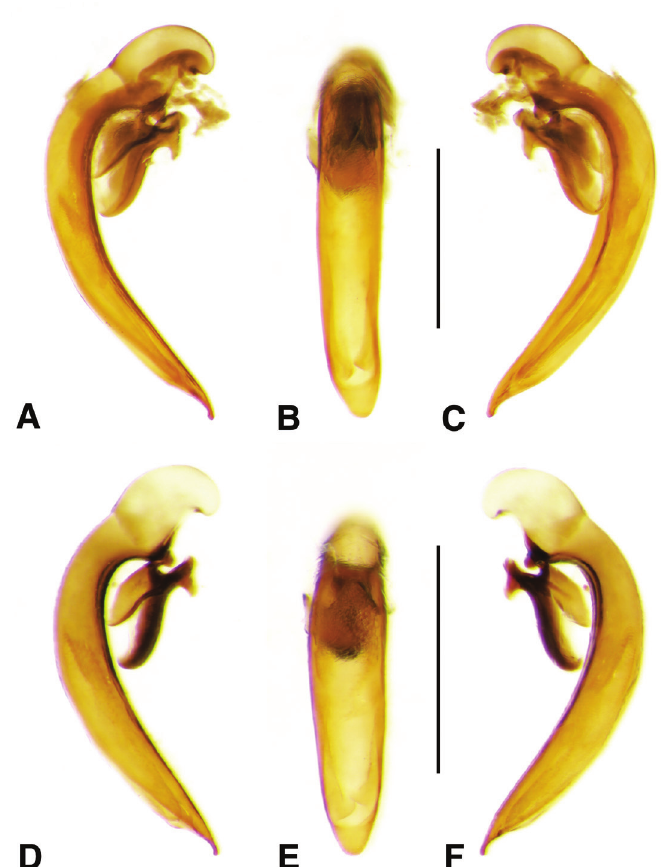
Figure 32. Digital images of male genitalia of Selenophorus mundus species group, in part. A, D and G right lateral aspect B, E, H dorsal aspect C, F, I left lateral aspect A–C S. mundus Putzeys D–F S. pseudomundus Ball & Shpeley. Scale bars 0.5